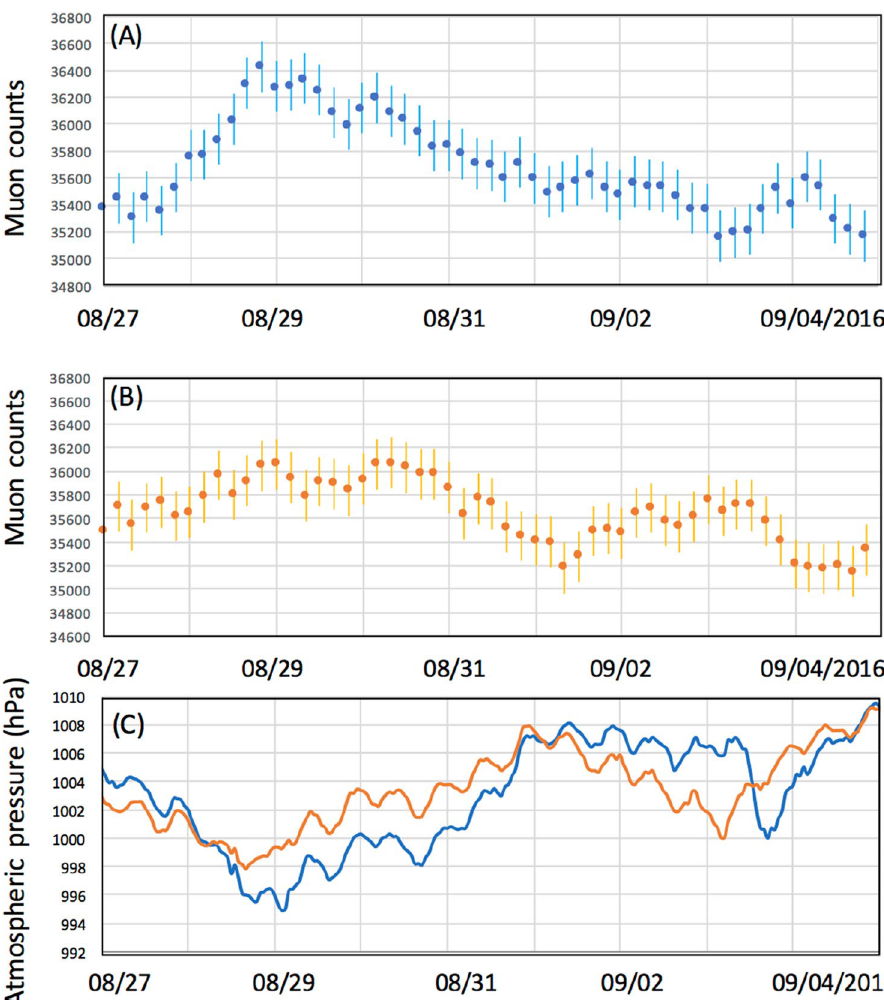
Figure 9. Observed time-sequential muon count rate at high (0.4 < tan θ < 0.8) ( A ) and low (0 < tan θ < 0.4) ( B ) elevation angles. The vertical bars associated with the data points indicate 1σ error bars. The time-dependent BP variations observed at Yakushima (blue) and Naze (orange) are also shown ( C ). The first pressure drop was associated with the T-1610 passage, and the second pressure drop was associated with the T-1612